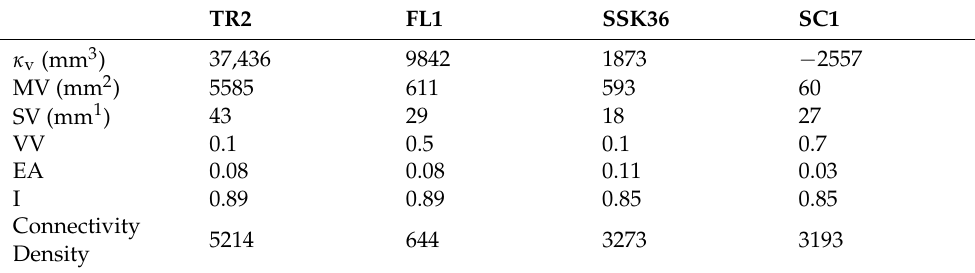
Table 3. Results of the Basic Analysis and the Connectivity Density computed from the Skeleton Analysis modules performed on the data sets of TR2, FL1, SSK36 and SC1 samples. TR2 FL1 SSK36 κ v (mm 3